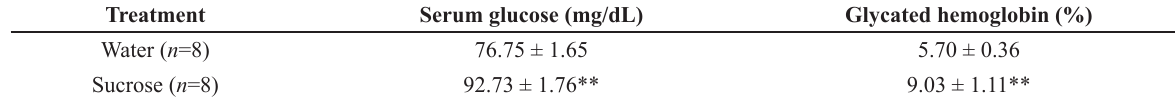
Influence of sucrose treatment on fasting glucose and glycated hemoglobin (A1C) in rats. Treatment